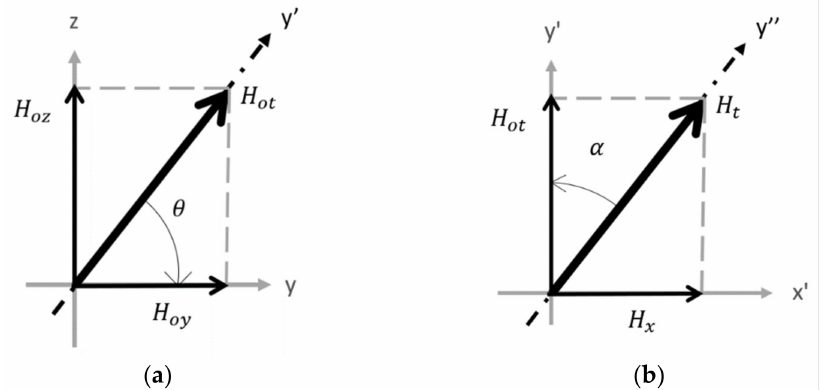
Figure 4. ( a ) Component Breakdown of the Static Field; ( b ) Dynamic Field Angle α Definition.